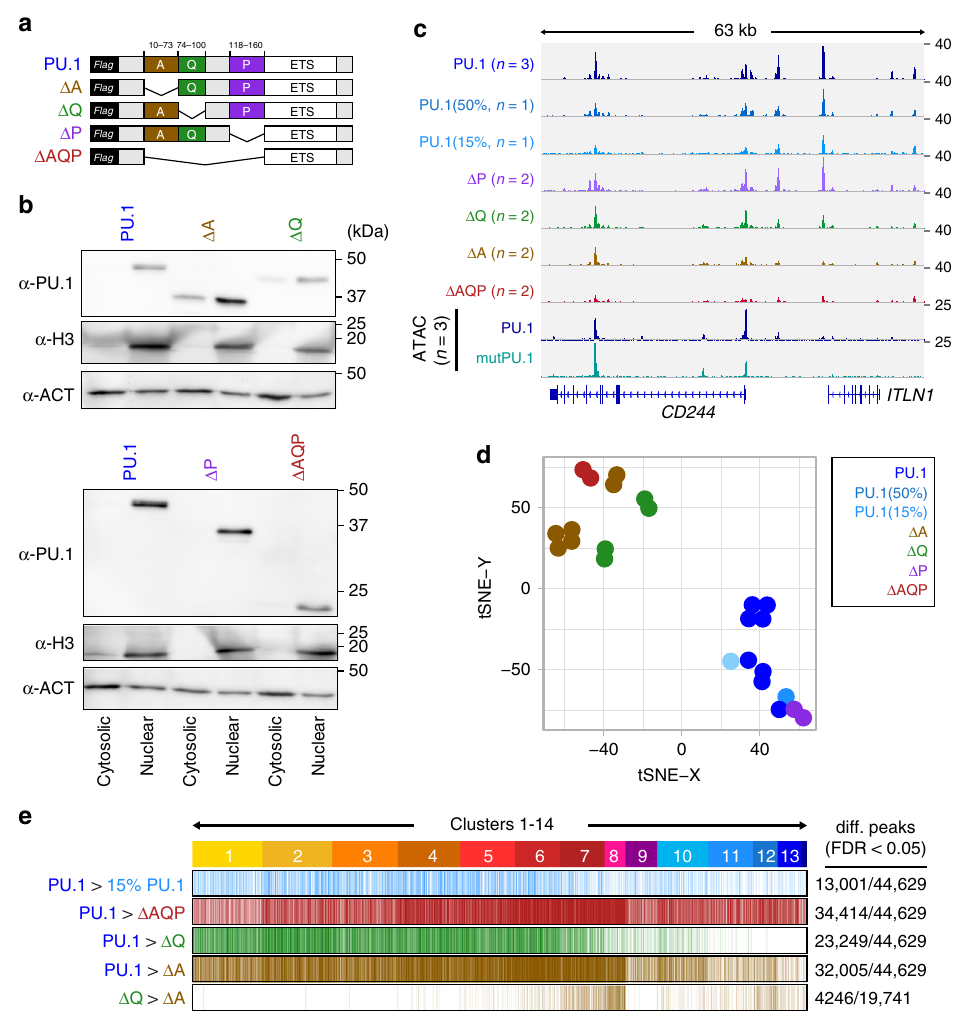
Fig. 7 Effect of PU.1 protein domains on chromatin access. a Design of PU.1-deletion mutants. The DNA-binding domain (ETS domain) was kept in all constructs and a 3 × -FLAG-tag was added N-terminal for detection. b Immunoblot con fi rming the nuclear expression of PU.1-deletion mutants compared with full-length PU.1 in transfected cells using IVT mRNA. c IGV genome browser tracks of the CD84 locus showing PU.1 ChIP-seq coverage of CTV-1 cells transfected with varying amounts of PU.1 IVT mRNA as well as PU.1 mutant mRNA. ATAC-seq coverage of CTV-1 cells transfected with PU.1 (blue) and mutPU.1 (turquoise) IVT mRNA is depicted in the two bottom rows. d Two-dimensional visualization of the distribution of the indicated samples across annotated PU.1 peaks using tSNE embedding. Replicates of the same mRNA transfections are indicated by coloring. e Differential ChIP-seq peaks of WT vs. less PU.1 (15%, light blue), WT vs. Δ AQP (red), WT vs. Δ Q (green), and WT vs. Δ A (brown), as well as differential peaks between Δ Q vs. Δ A (brown) are shown across ATAC-seq-derived PU.1 peak clusters (introduced in Fig. 3). b – e Source data are provided as a Source Data fi